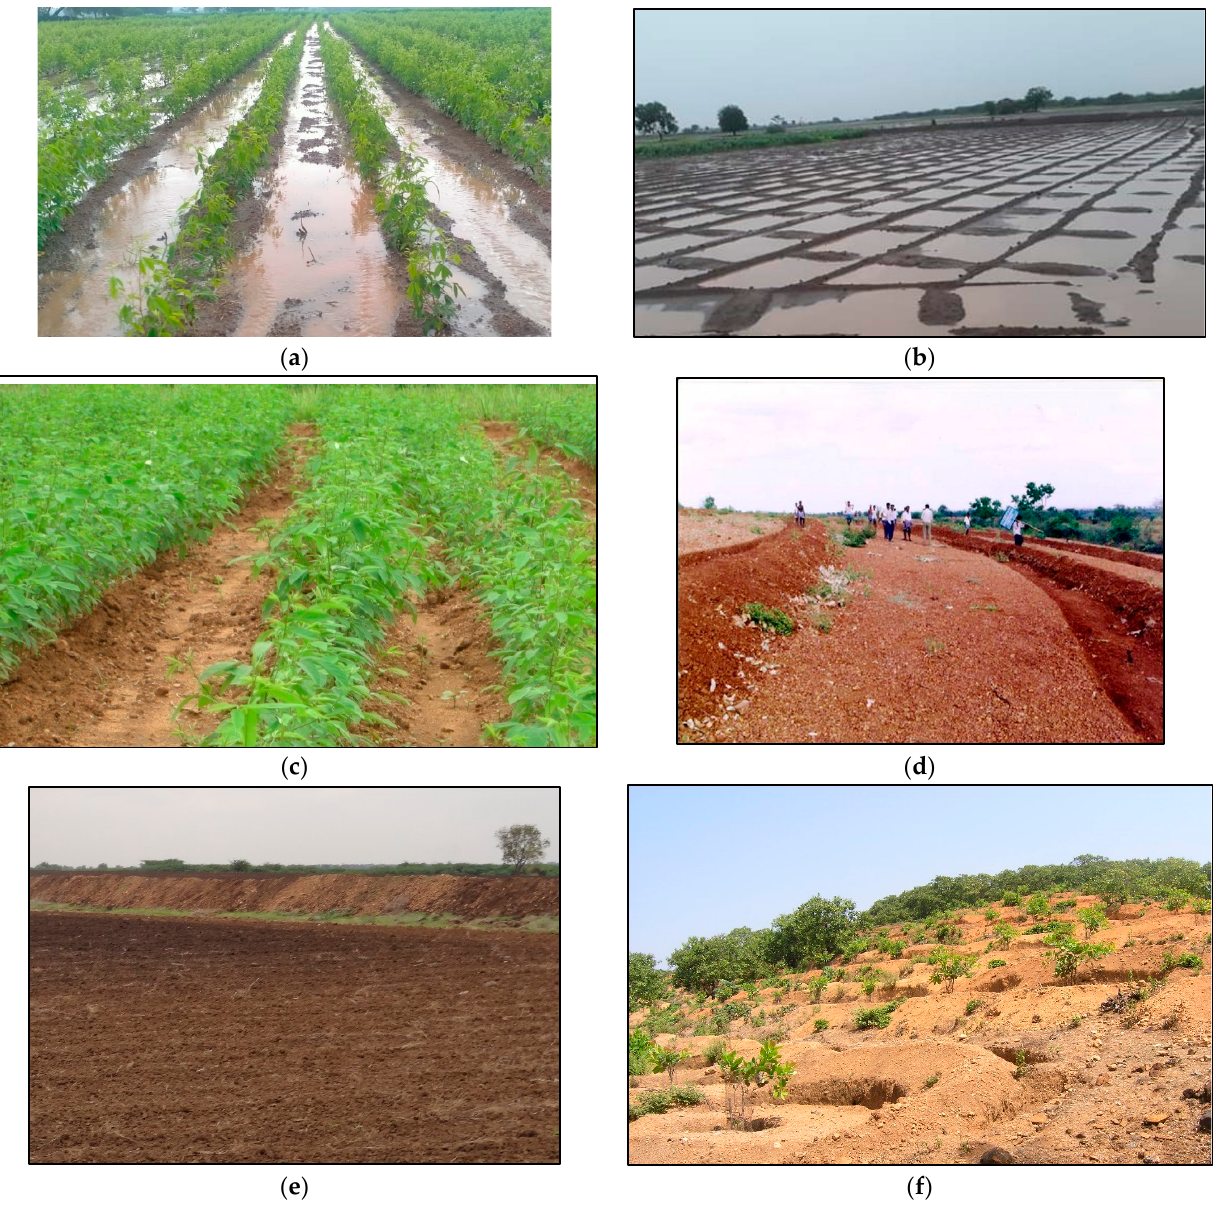
Figure 8. Soil and water conservation interventions existing in Karnataka. ( a ) Broad bed furrow (BBF), ( b ) compartmental bunding, ( c ) conservation furrow, ( d ) contour bunds, ( e ) graded bunds, and ( f ) semi-circular/crescent